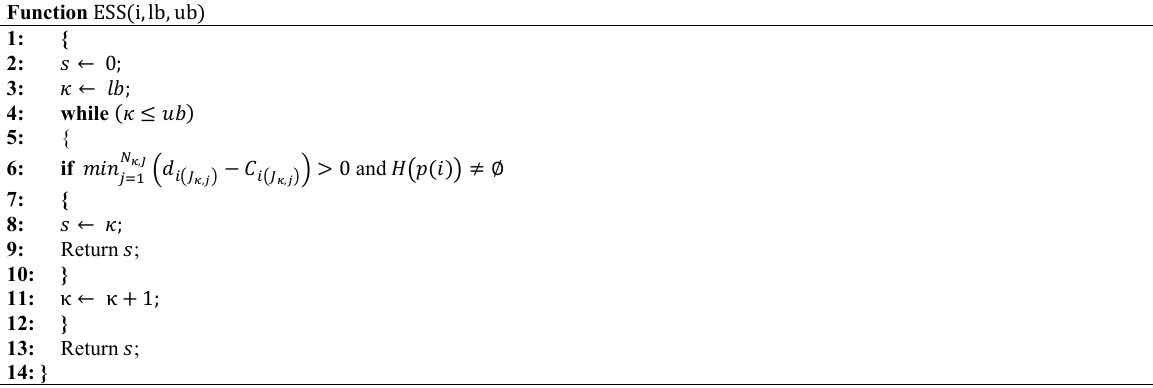
Fig. 5. Pseudocode for Function